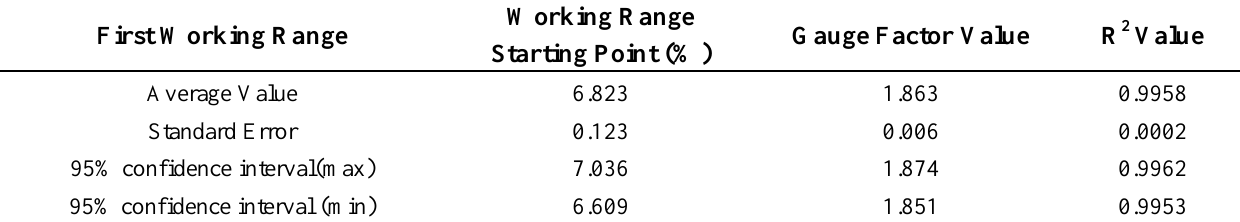
Table 9. Statistical results of samples with conductive yarn of 20 cN input